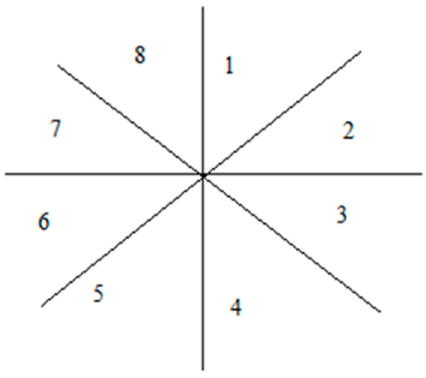
Figure 5. Kernel parts enumeration.